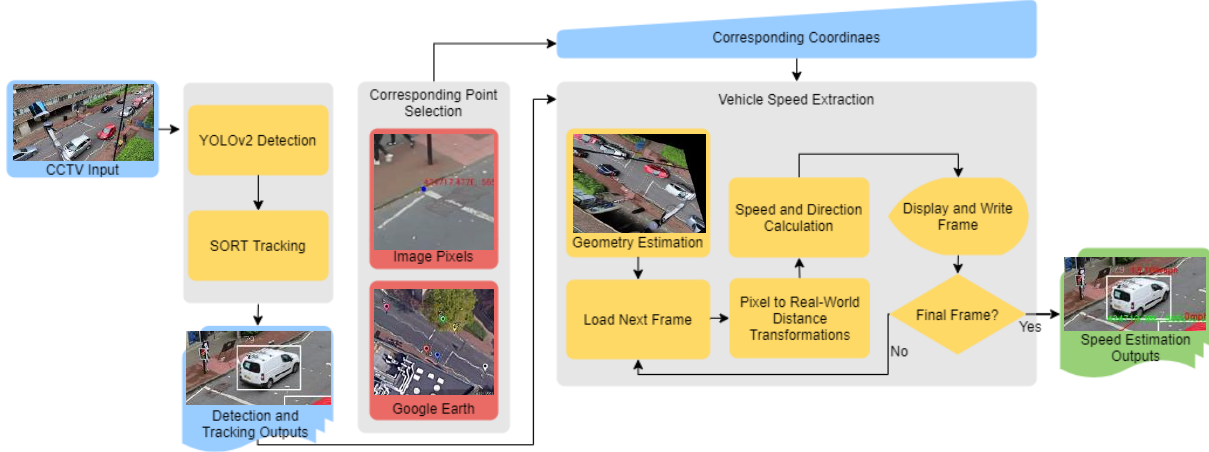
Figure 1. Processing